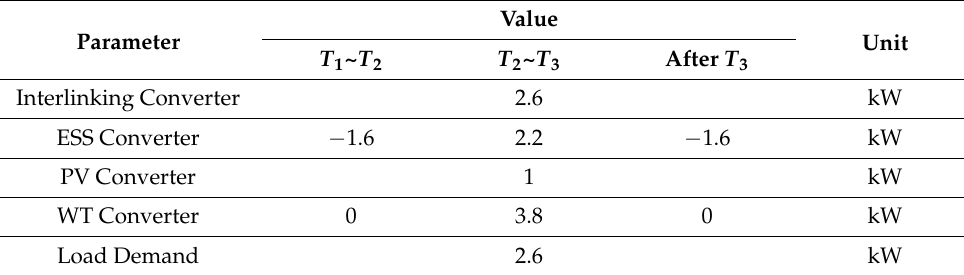
Table 7. Power flow of each power converter in operation mode 4.